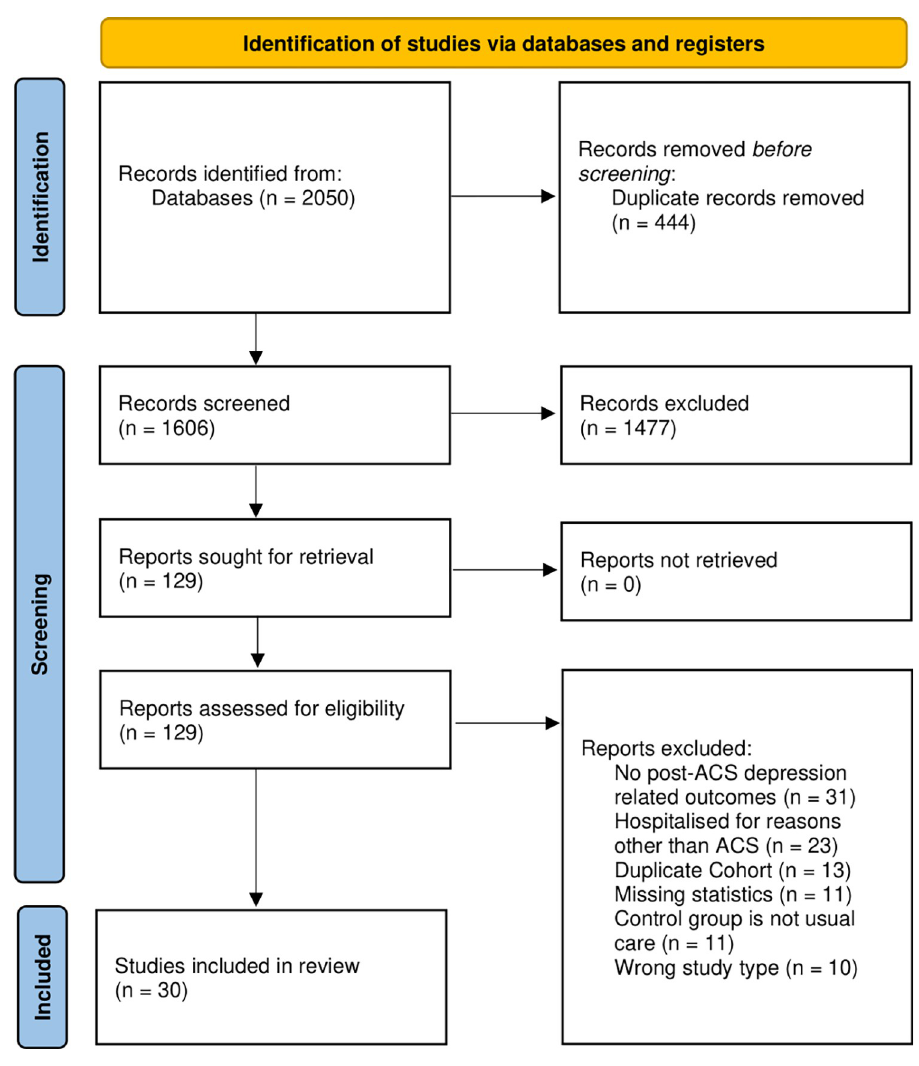
Fig 1. PRISMA flow